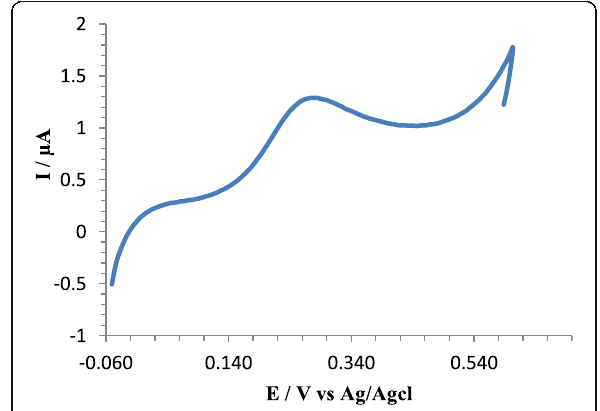
Fig. 2 Cyclic voltammogram for the oxidation of ferrocene tagged antibody to ferrocenium cation that catalyses luminol/hydrogen peroxide showing an oxidation peak at + 0.25 V. Scan rate 10 mV s −